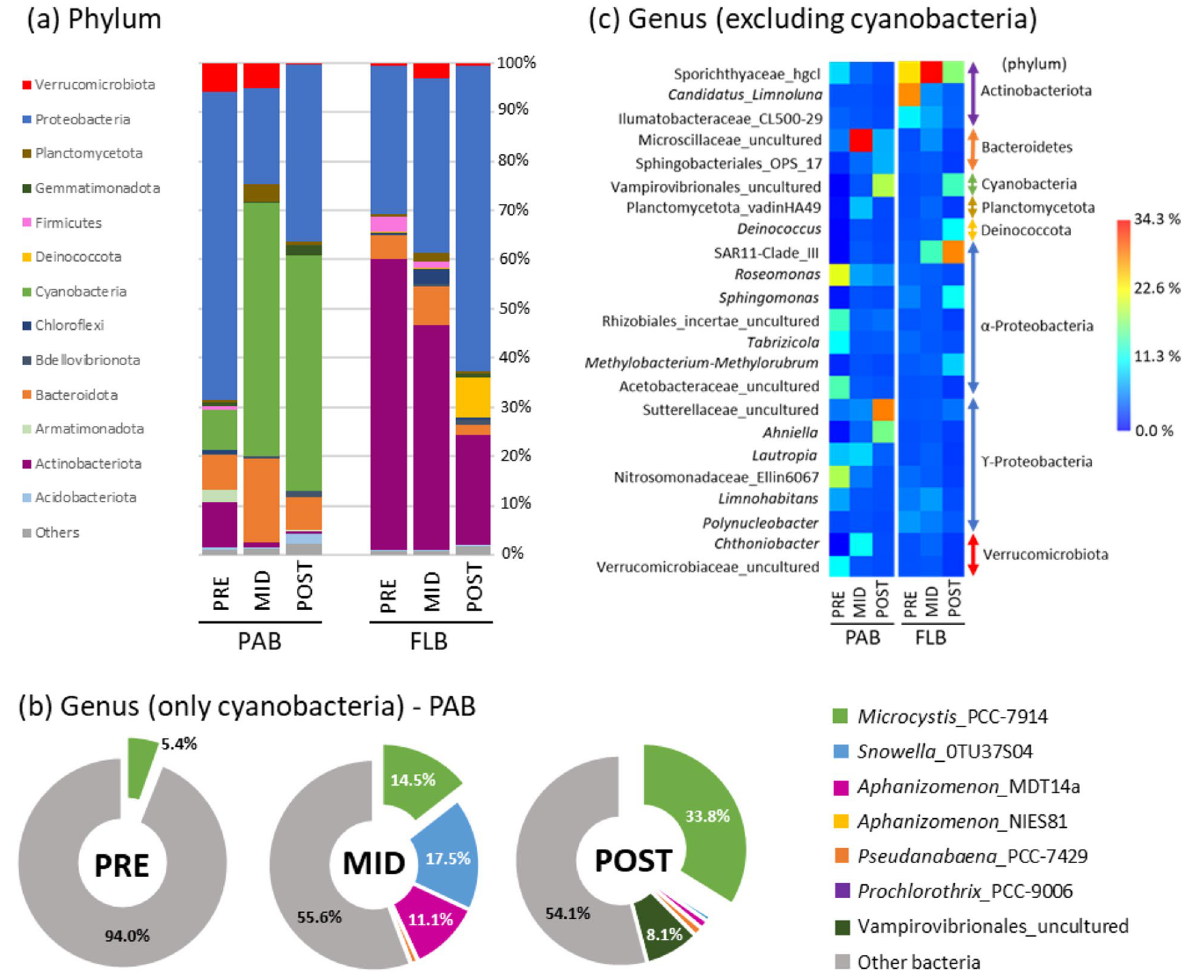
Figure 1. Relative abundance (%) of PAB and FLB communities using 16S rRNA sequencing during the development of a Microcystis toxigenic bloom in summer. Overall relative abundances for each taxa are average estimates of relative abundances obtained across samples per period of collection (5–7 replicates, see Supplementary Table S1). Abundances were described to the level of Phylum ( a ), and in the case of genera, cyanobacteria were retrieved from PAB communities and analysed separately ( b and c , respectively). Unclassified sequences and other taxa with lower relative abundance (< 3%) were excluded in ( c ). PAB particle- attached bacteria, FLB free-living bacteria, PRE pre-summer period, MID mid-summer period, POST post- summer in the POST (14.9 and 683 µg L −1 , respectively). For the case of PO 43- , the concentration was the highest in PRE (75 µg L −1 ) when compared to the subsequent MID and POST (23 and 29 µg L −1 , respectively). Bacterioplankton community composition. A total of 2,835,952 good-quality reads (83.0%) were obtained from an original database containing 3,415,730 raw reads after 16S rRNA sequencing. Furthermore, 2,315,086 reads (67.8%) were classified with 99% similarity to bacteria (Supplementary material Table S1). A total of 2976 OTUs (PAB: 1485 and FLB: 1491) were assigned to 36 phyla, 84 classes, 211 orders, 351 families, and 698 genera. In general, the predominant phyla in PAB were represented by Proteobacteria (41.5%), Cyano- bacteria (32.6%), and Bacteroidota (11.0%), and in FLB by Proteobacteria (37.8%) and Actinobacteria (36.6%) (Supplementary material Table S2). Classified reads are visualized as the total relative abundance of the gene 16S rRNA representing different bacterioplankton communities for the summer season in Fig. 1 and Table S3. For PAB community, Proteo- bacteria was the most abundant phylum in PRE (62.5%), while Cyanobacteria increased considerably in the subsequent MID (51.4%) and POST (47.9%). Other phyla included Bacteroidota and Planctomycetota with their highest increase in MID (17.1% and 3.5%, respectively) (Fig. 1a). In the case of genus, cyanobacteria were removed from the PAB consortia and analysed separately, in order to investigate the relative weight importance (%) of attached-bacteria without cyanobacteria. The results indicated that cyanobacteria were the most abun- dant in MID with three genera belonging to Snowella _OTU37S04 (17.5%), Microcystis _PCC7914 (14.5%), and